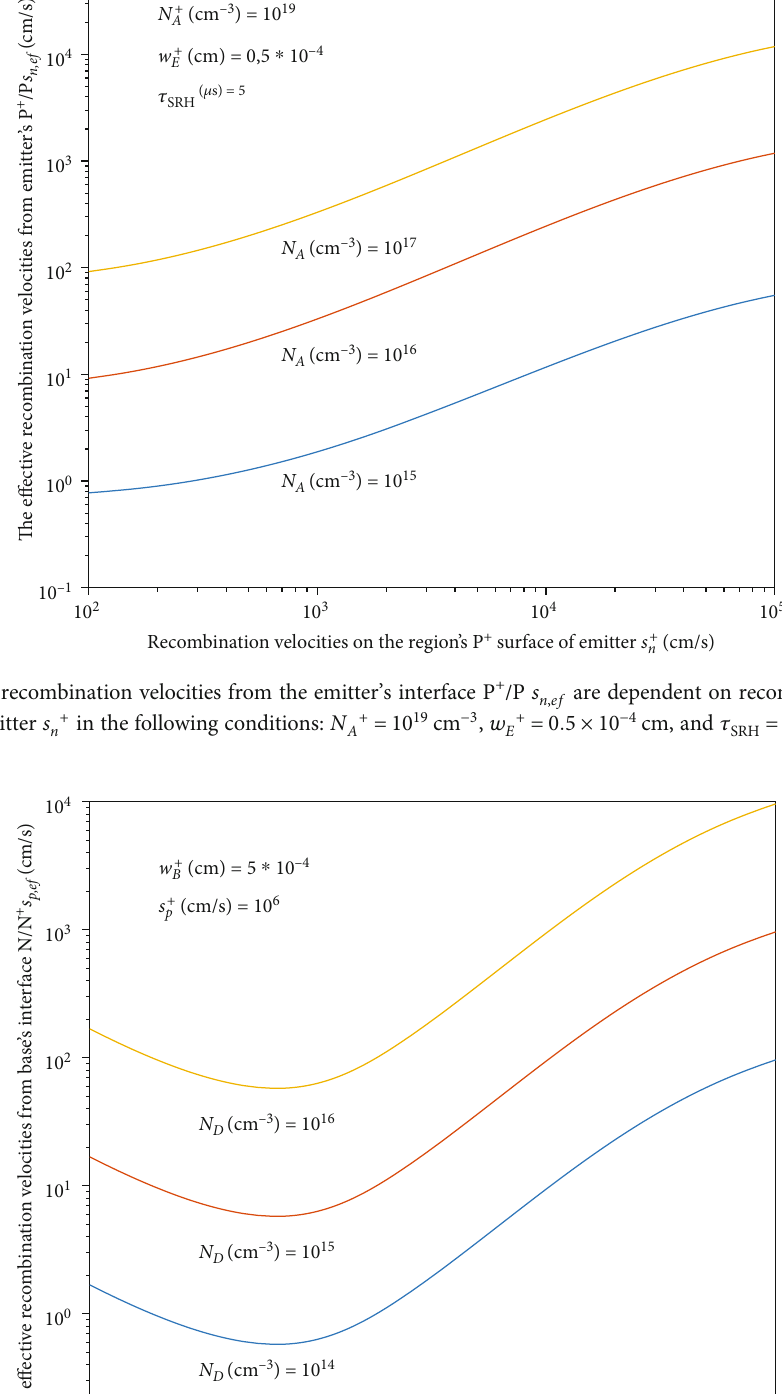
Figure 13: The e ff ective recombination velocities from base ’ s interface N/N + s the case of w B + = 5 × 10 − 4 cm and s p + = 10 6 cm/s